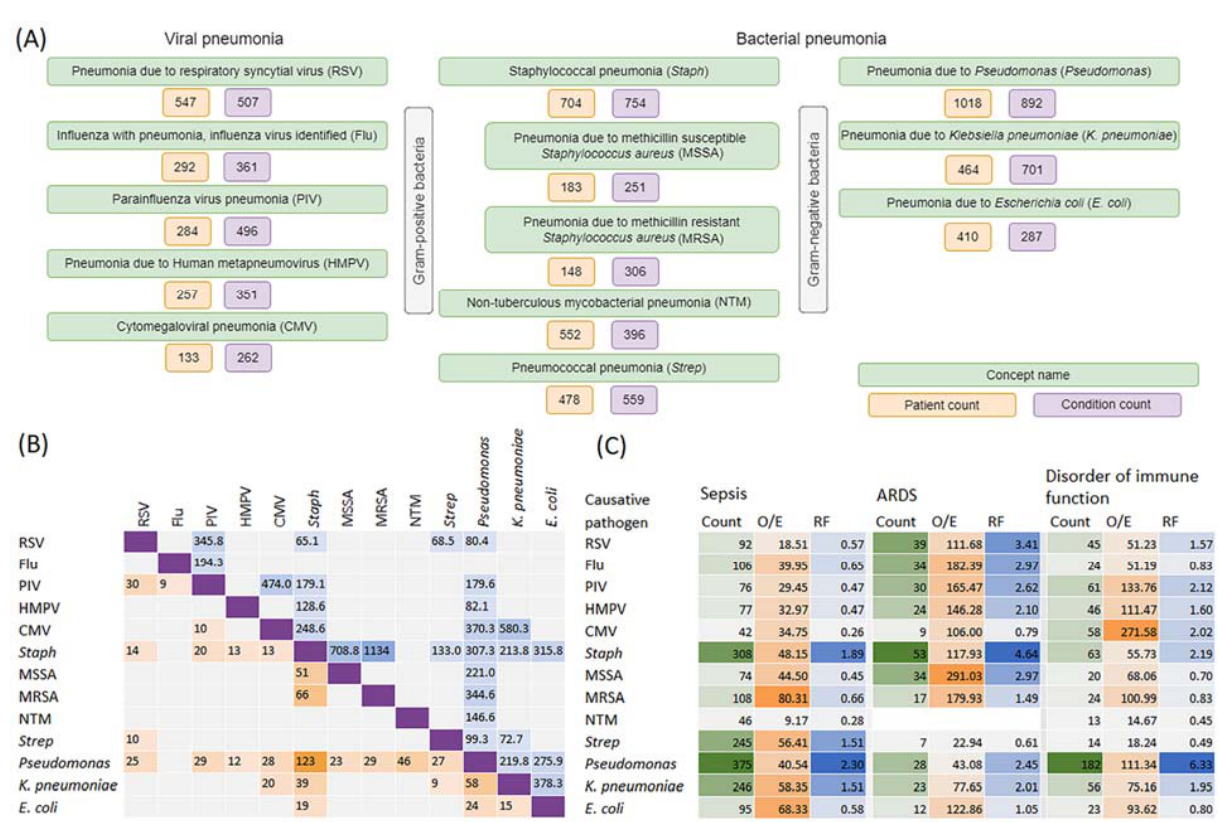
Figure 3. Pathogen-specific pneumonia concepts in the 5-year non-hierarchical COHD dataset. ( A ) Summary data reflecting the patient and co-occurring condition count for 13 pathogen-specific types of pneumonia. ( B ) Heat-map matrix for co-occurring types of pathogen-specific pneumonia: observed-to-expected frequency ratios (O/E) (above the purple diagonal divider) and the patient count in co-occurring conditions (below the purple diagonal divider). ( C ) O/E and relative frequen- cies (RF) of pathogen-specific pneumonia in patients with sepsis, acute respiratory distress syndrome (ARDS) and disorder of immune function. The natural logarithm of the O/E ratio has been converted back to the original scale.